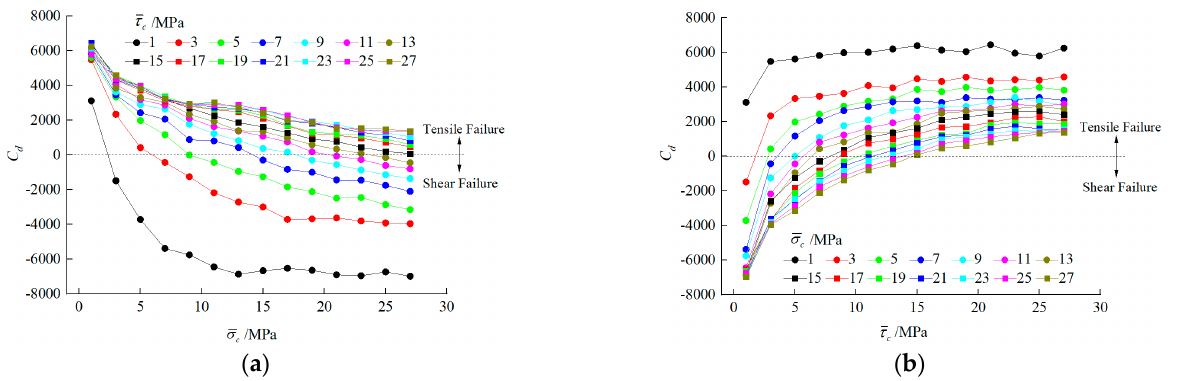
Figure 3. Effects of bond strength on the difference in quantity between tensile cracks and shear cracks: ( a ) tensile bond strength; ( b ) shear bond strength. cracks: ( a ) tensile bond strength; ( b ) shear bond